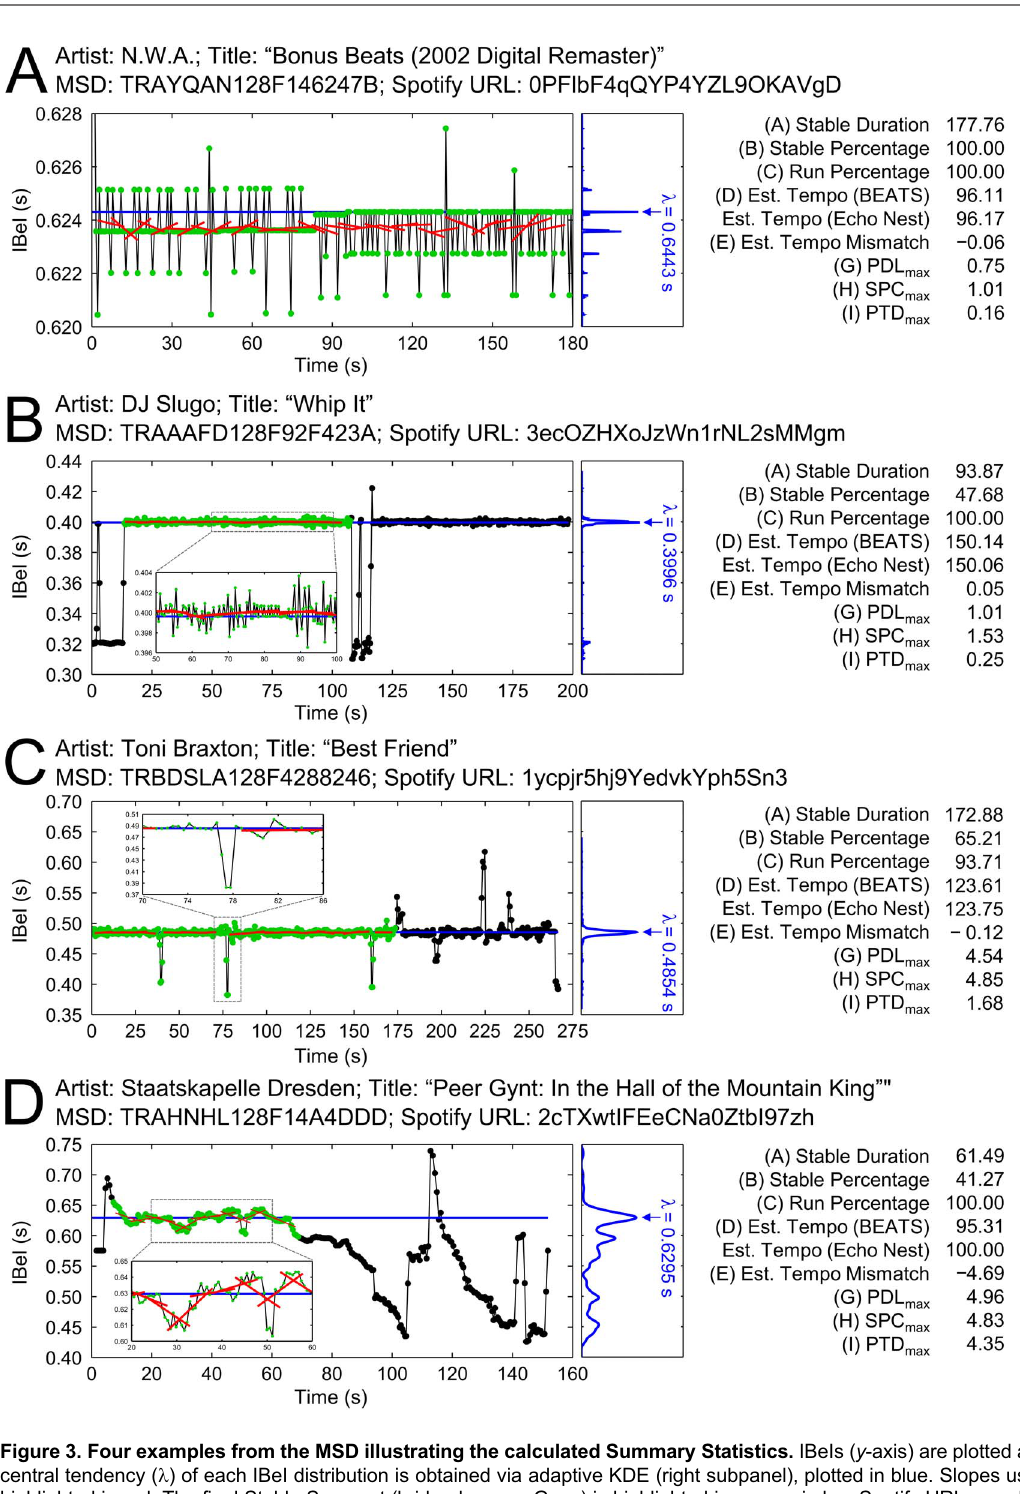
Figure 3. Four examples from the MSD illustrating the calculated Summary Statistics. IBeIs ( y -axis) are plotted as a function of real time ( x -axis). The central tendency ( l ) of each IBeI distribution is obtained via adaptive KDE (right subpanel), plotted in blue. Slopes used to calculate PTD max statistics are highlighted in red. The final Stable Segment (bridged across Gaps) is highlighted in green circles. Spotify URLs can be suffixed to https://play.spotify.com/ track/ for listening.